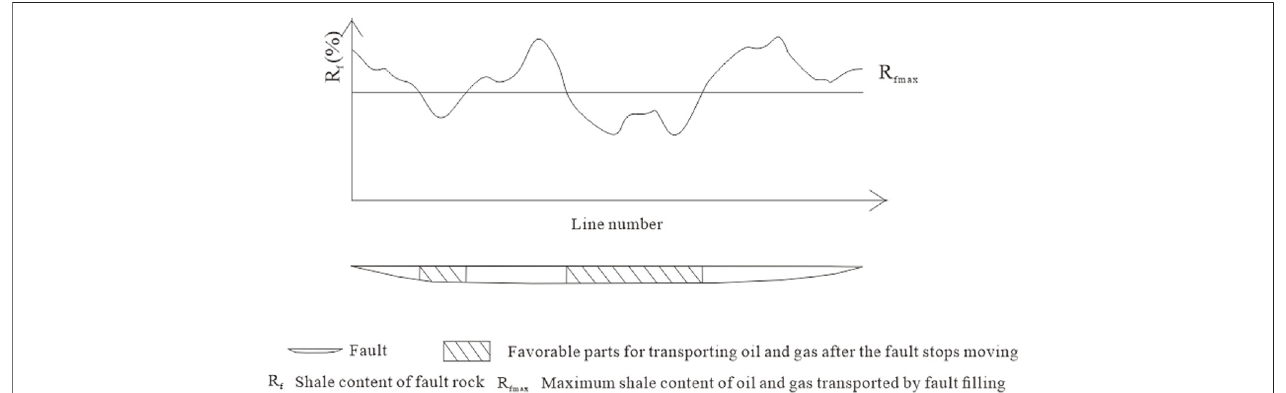
FIGURE 5 | Schematic diagram of determining the favorable position of the source fault con fi guration to transport oil and gas after the fault ceases to be active.